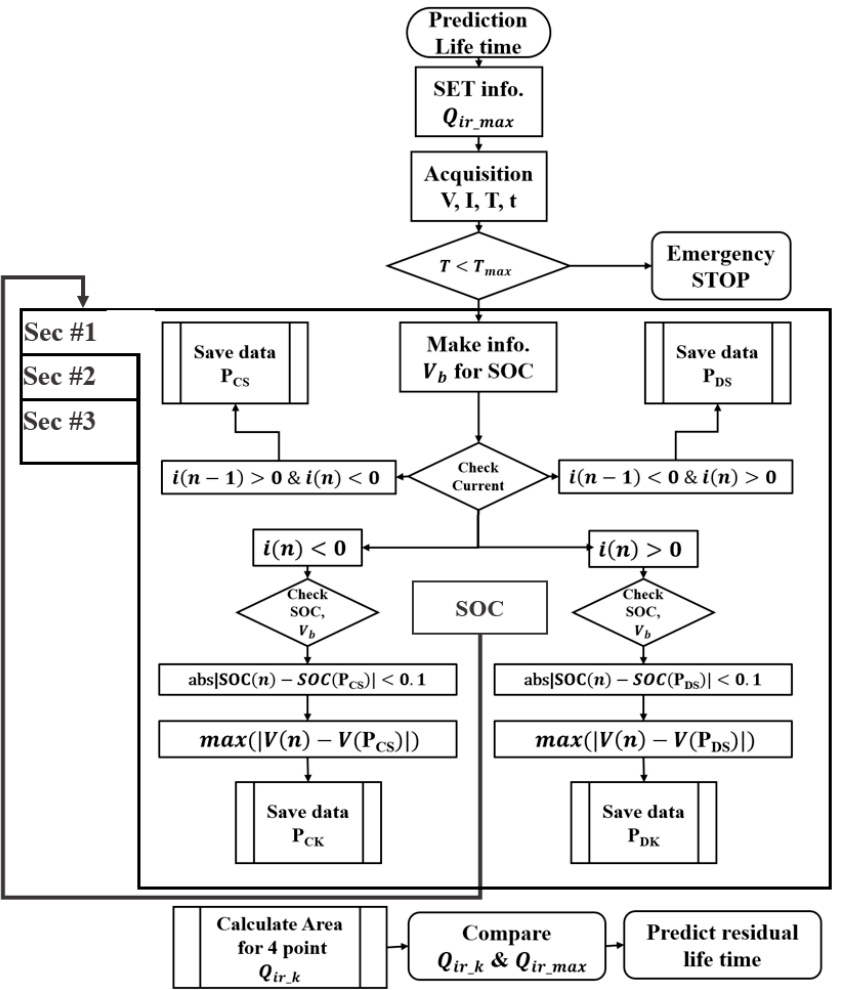
Figure 9. The algorithm for predicting residual lifetime.